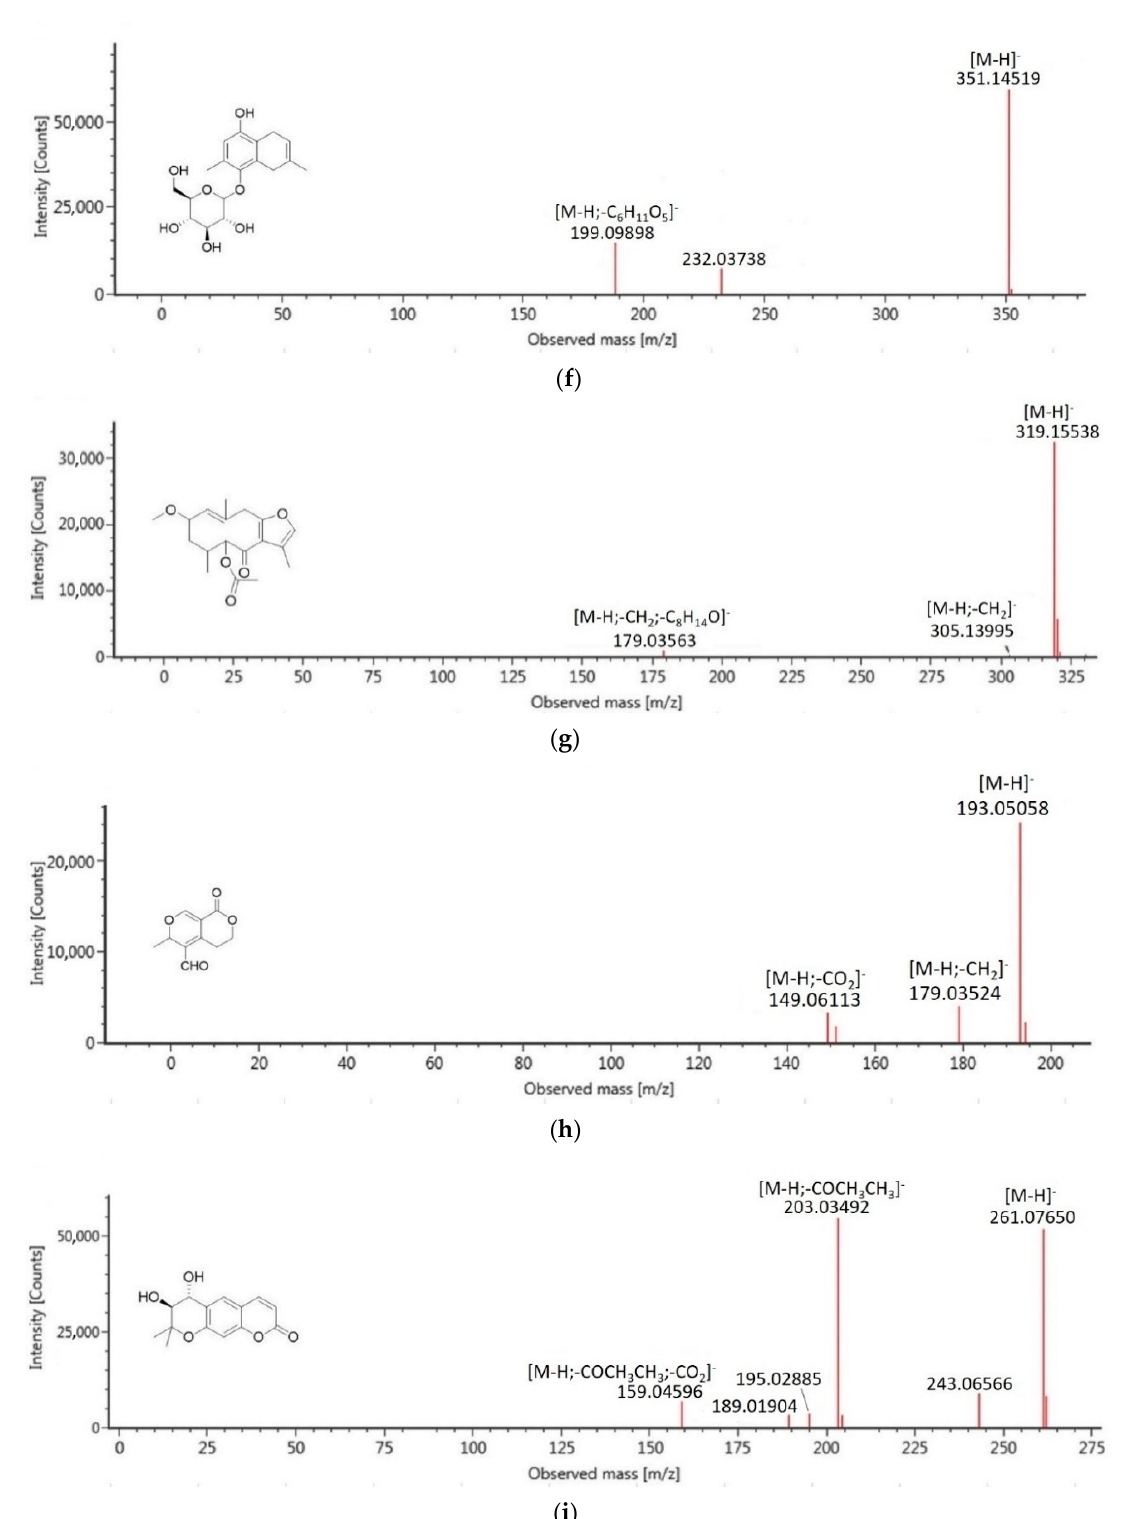
Figure 2. MS/MS spectra fragmentation of tentatively identified compounds from CF4: ( a ) 4 ′ ,5,6,7-tetramethoxy-flavone, ( b ) quercetagetin-3,4 ′ -dimethyl ether, ( c ) 5,3 ′ ,4 ′ -trihydroxy-6,7-dimethoxy-flavone, ( d ) isorhamnetin, ( e ) methyl 3,4,5-trimethoxycinnamate, ( f ) renifolin, ( g ) 2-methoxy-5-acetoxy-fruranogermacr-1(10)-en-6-one, ( h ) swermirin, ( i ) trans-decursidinol.